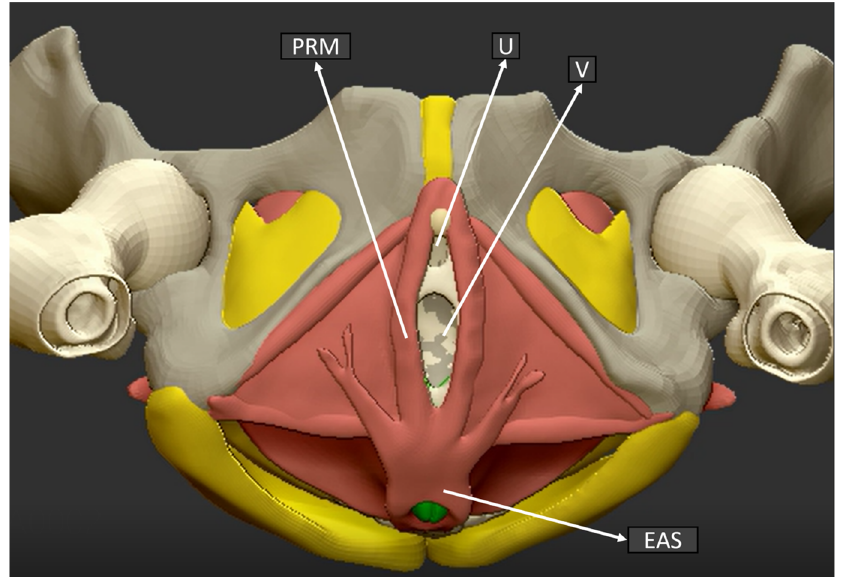
Figure 3. Pelvic floor anatomical structure coronal plane. (U) Urethra, (V) Vagina, (PRM) Puborectalis muscle, (EAS) External anal sphincter.